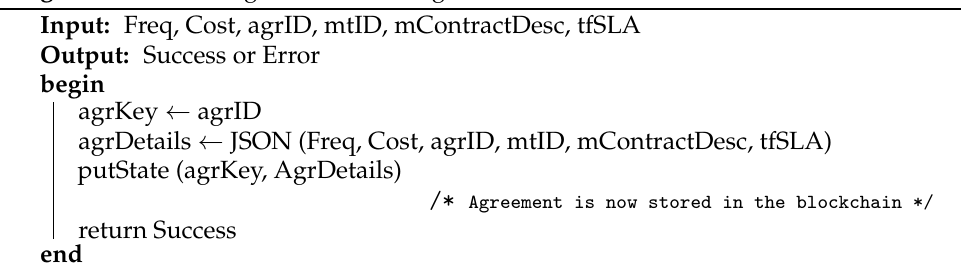
Algorithm 1: Creating Maintenance